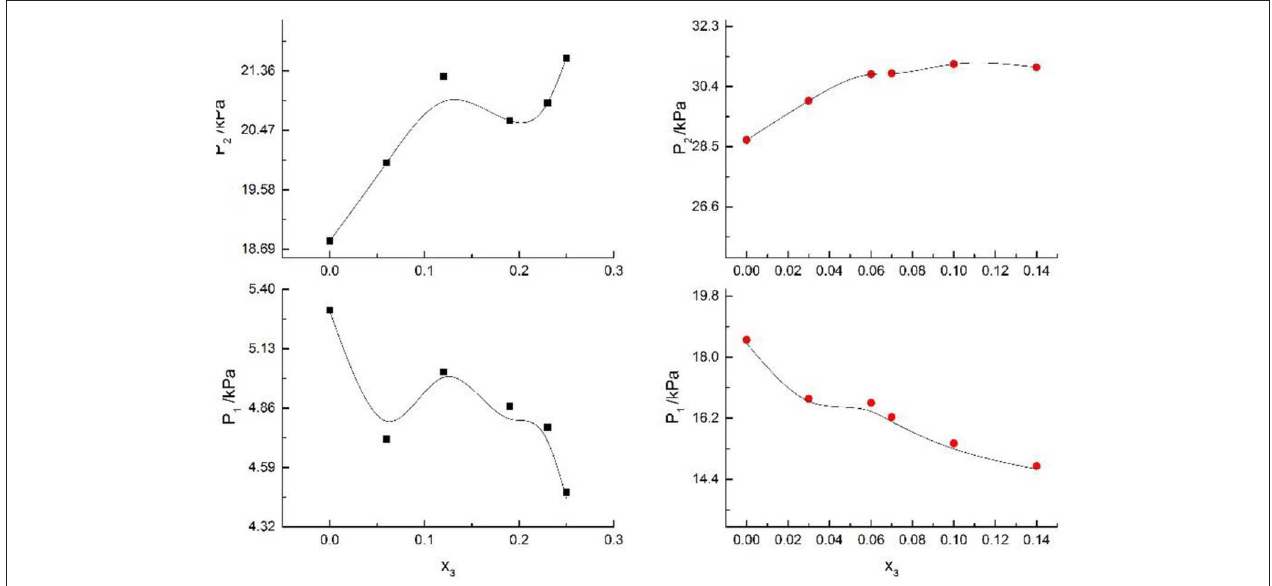
FIGURE 5 | Correlation of VLE data of H2O(1) + CH3OH(2) + NaCl(3) system. Filled symbols ( (cid:4) x2 = 0.45, T = 315K; • x2 = 0.22, T = 335K) indicate Literature data ( Yang and Lee, 1998). Curves indicate correlation of the model.